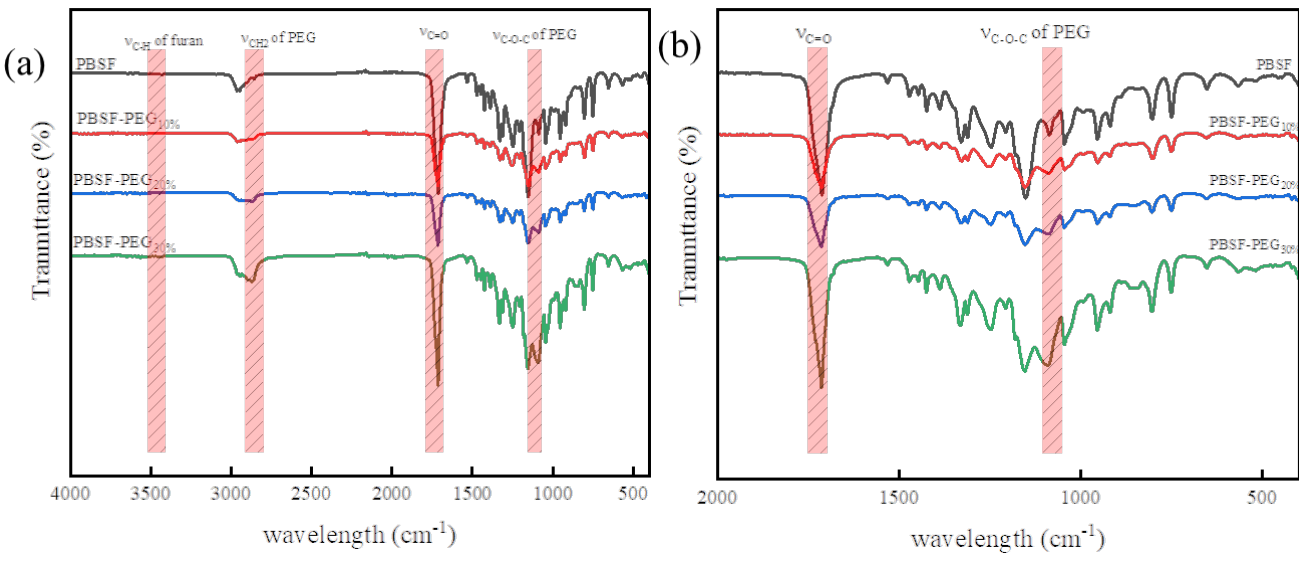
Figure 3. ATR-FTIR spectra of the copolymers ( a ) 4000 – 500 cm −1 , ( b ) 2000 – 500 cm −1 .